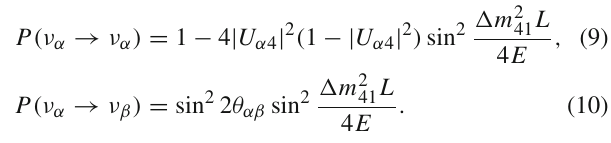
charm quarks contribute to the neutrino interaction. Right : The event topology of ν τ CC interactions that produce beauty hadrons. For sim- plicity, the conjugate diagrams are